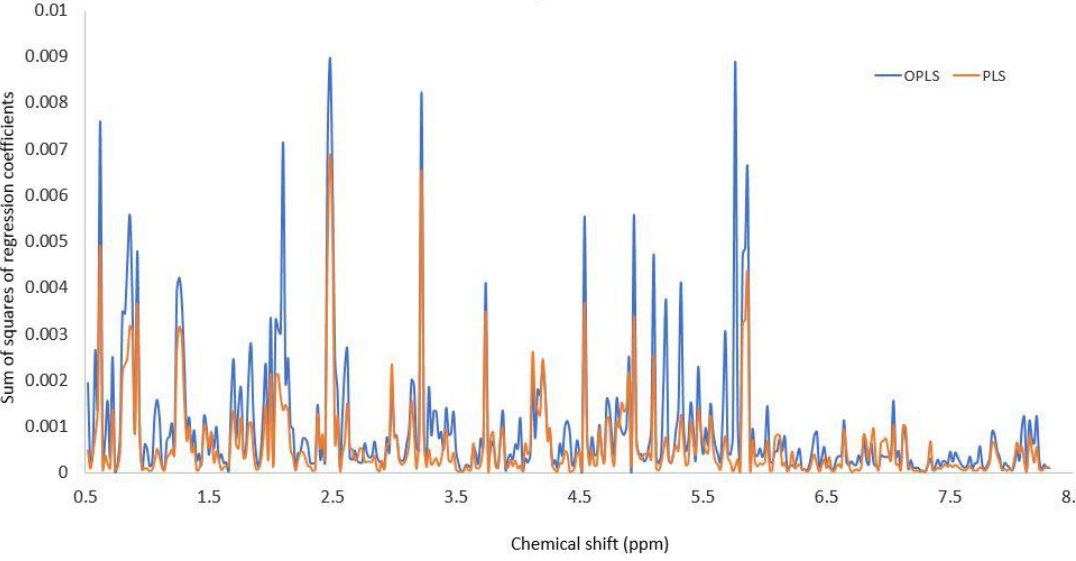
Figure 7. Sum of squares of the regression coefficient vectors of the PLS and OPLS models for all